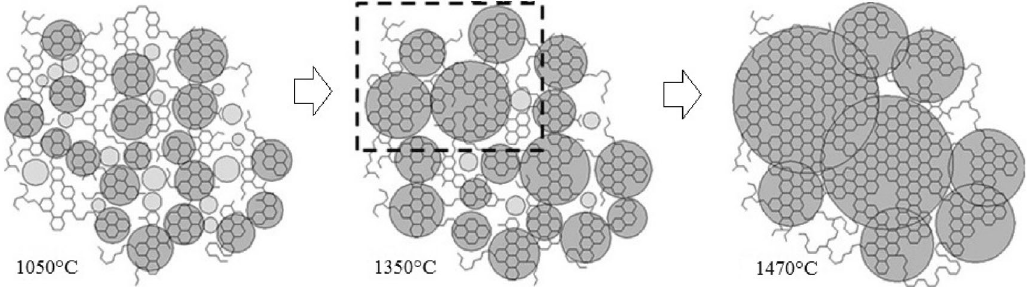
Fig. 6 Graphical implementation of graphitization degree versus heating